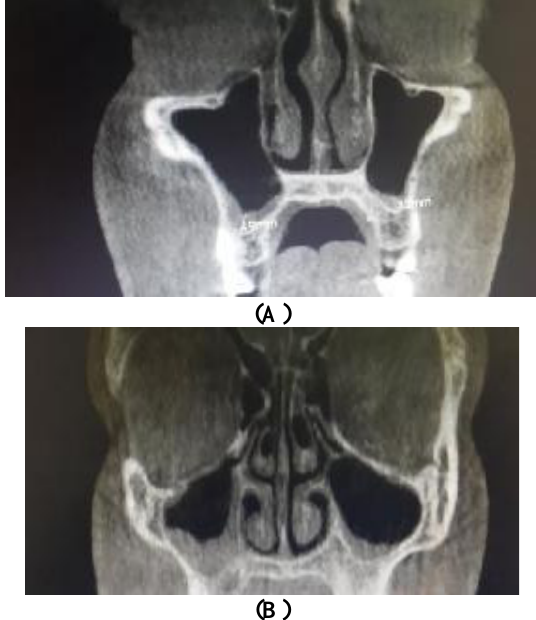
Figure 1: (A&B) Coronal View Showing Bilateral Thickening of Maxillary Sinus Membrane.